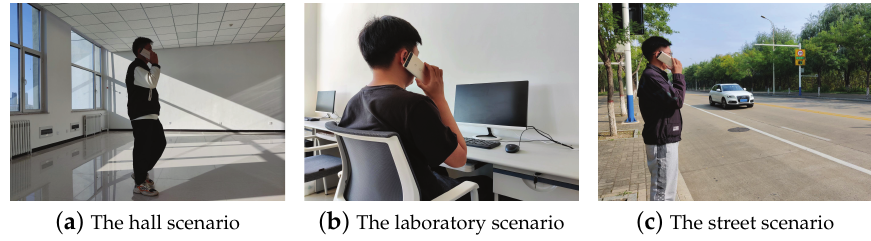
Figure 9. Three scenarios for data